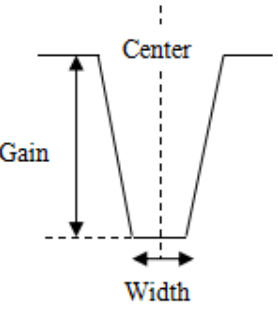
Figure 9. Trap filter order tracking principle.